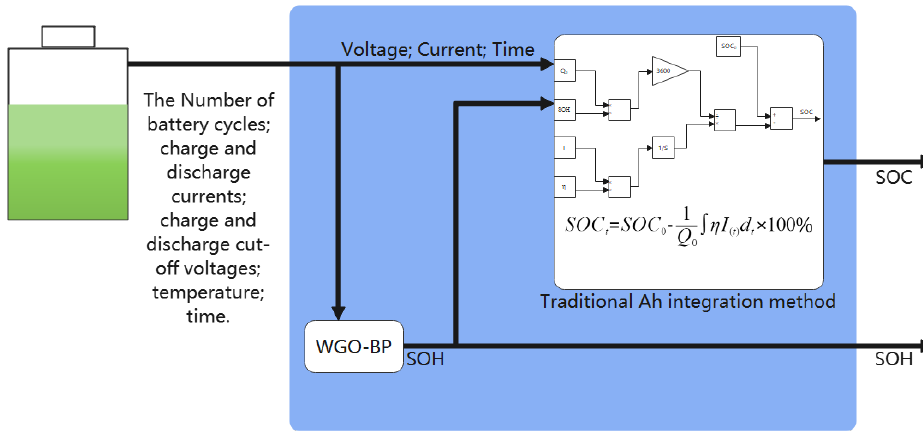
Figure 11. Schematic diagram of the SOH-SOC estimation model.